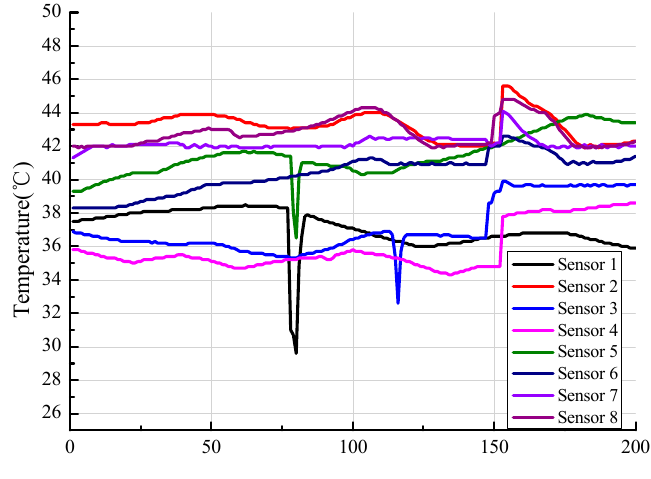
Figure 18. Experimental result of each sensor.